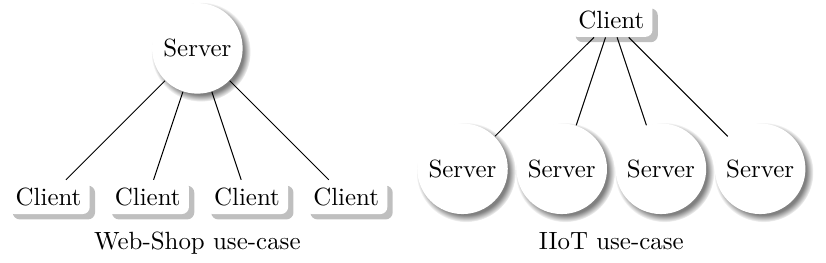
Figure 1: Use-cases for conventional Internet applications and